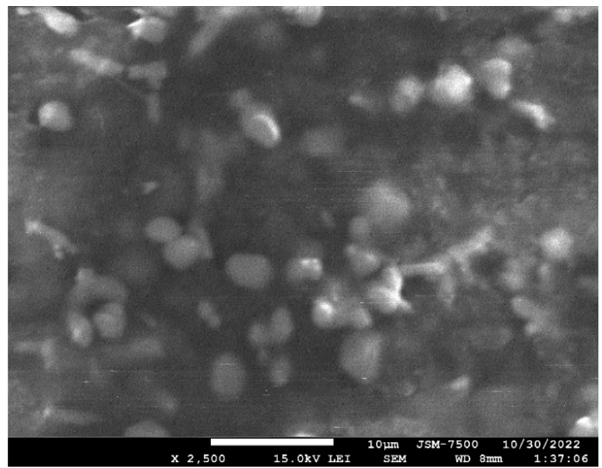
Figure 9. COMPO image of the PLA–40% weight MgFe 2 O 4